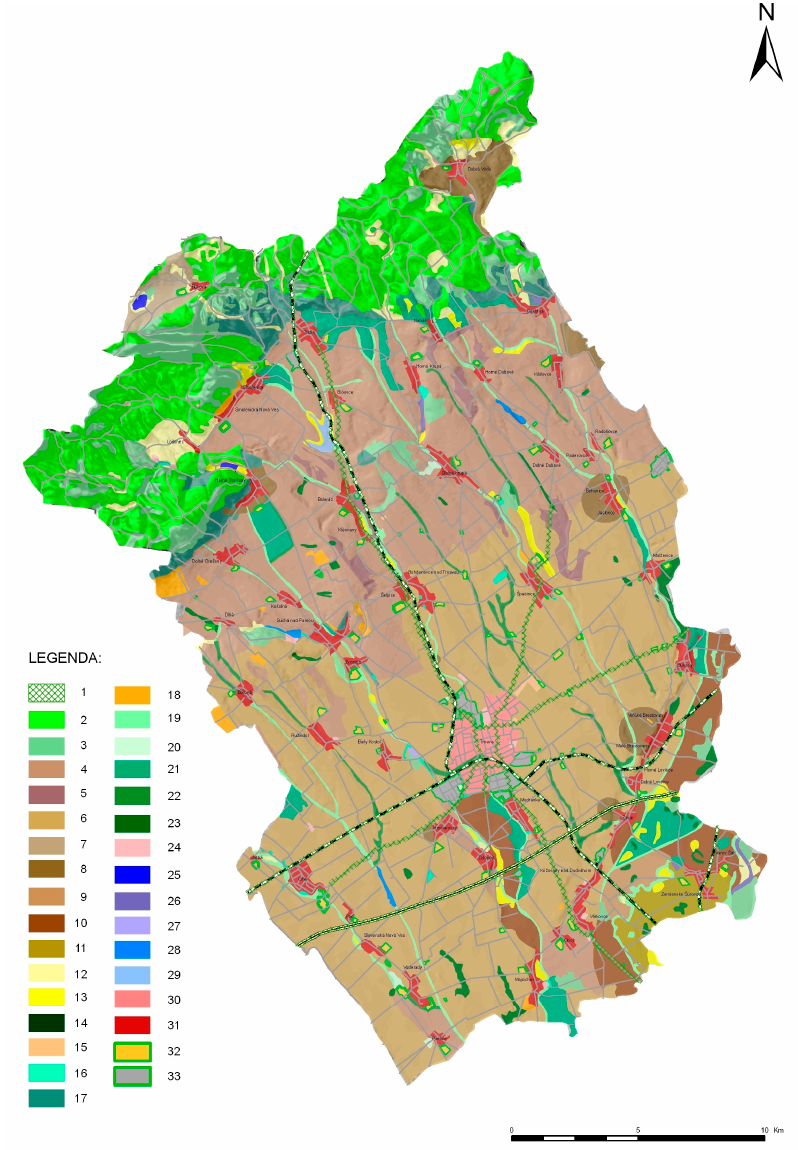
Figure 5. Proposal for optimal land use of the study area. Legend: 1. Green infrastructure of industrial zone; 2. Extensive forest management; 3. Protected forests; 4. Extensive agriculture—small arable fields; 5. Erosion control on small arable fields; 6. Intensive agriculture—large-block arable lands; 7. Extensive agriculture for protected karst areas; 8. Extensive agriculture for water protection; 9. Extensive agriculture for the protection of water resources and mineral resources; 10. Agriculture with special management for contaminated soil; 11. Agriculture with special management for soil contamination and water protection; 12. Intensively managed meadows; 13. Extensively managed wooded grasslands; 14. Recreational park; 15. Extensively managed grasslands; 16. Extensive agriculture in gardens and orchards; 17. Extensive agriculture in mosaics of gardens, arable lands, and grasslands; 18. Extensive agriculture in vineyards; 19. Water protected area—floodplain vegetation; 20. City green infrastructure; 21. Extensive agriculture of mosaics of arable lands and grasslands; 22. Nature protection; 23. Open landscape green infrastructure; 24. Recreation zone with cottages; 25. Recreation zone for water sport; 26. Recreation zone for fishing; 27. Recreation zone for fishing, with nature protection restriction; 28. Water reservoir for irrigation; 29. Living area—block of flats; 30. Living area—individual houses; 31. Built-up area—agricultural buildings; 32. Built-up area—industrial buildings; 33. Industrial zone.